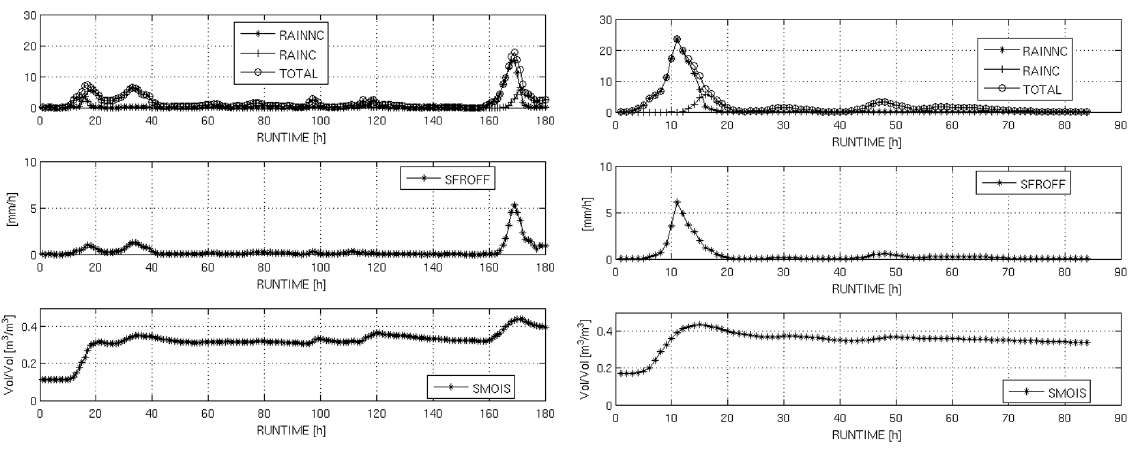
Fig. 14. Simulated hourly precipitation (convective=RAINC and grid-scale=RAINNC), water runoff and soil moisture content at Funchal. Left panel: Run6 (starting at 12:00 UTC, 13 February to 00:00 UTC 21 February). Right panel: RunPrev (starting at 00:00 20 February to 12:00 UTC 23 February).